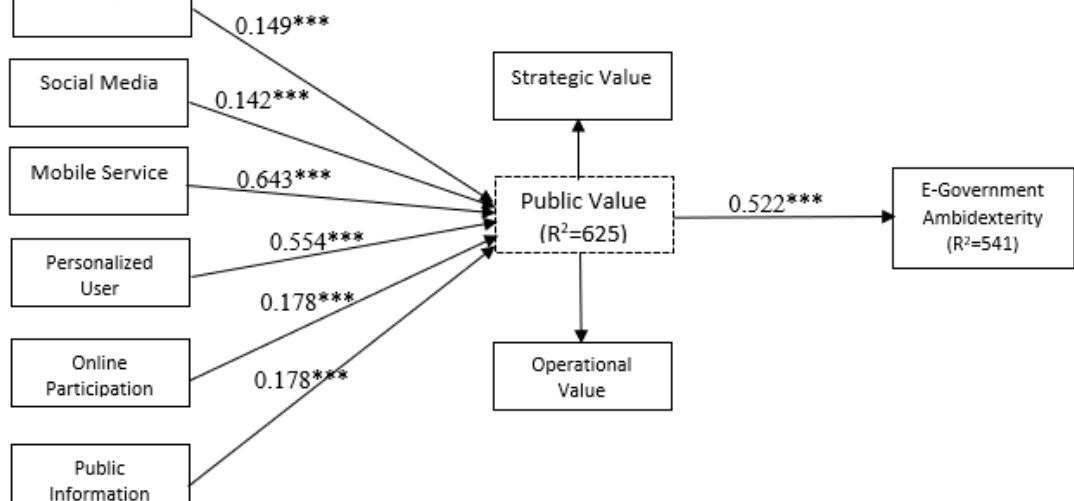
Figure 2. Results of the research model. Note: *** p -value < 0.001.